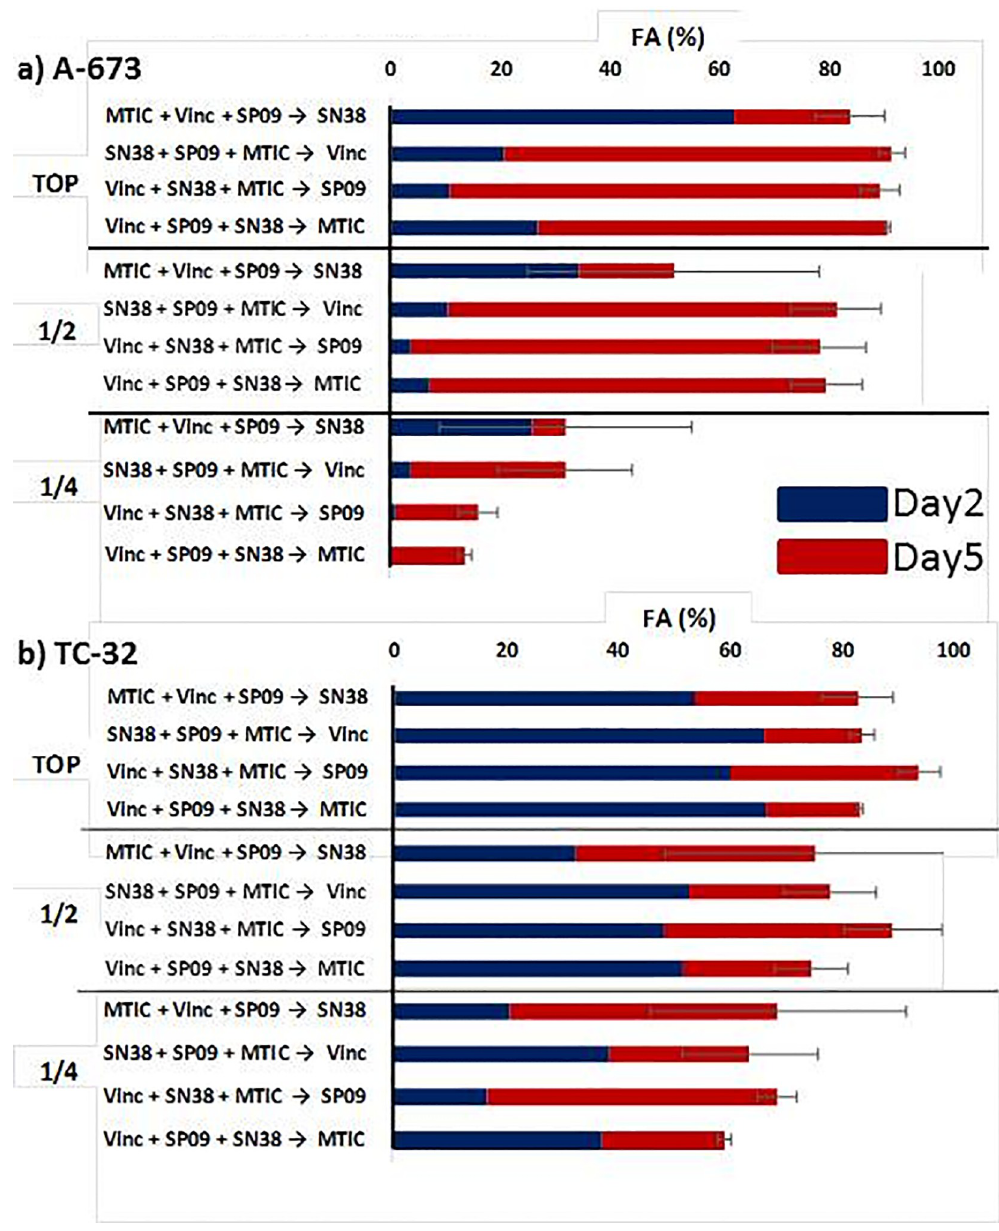
Fig 3. Vincristine, irinotecan, temozolomide, and SP2509 order of addition. Results of order of addition experiments for a) A673 and b) TC32, respectively. One to three drugs were given concurrently 24 hours after plating and read on Day 2. The fourth drug was added after the 48 hour read and the same experimental plate was read on Day 5. TOP represents the highest concentration used as indicated in Table 3B; ½ is half the highest concentration, ¼ is a quarter of the highest concentration. Error bars represent standard error of the mean. A673 n = 2, TC32 n = 4. See S1 Fig for all order of addition results.